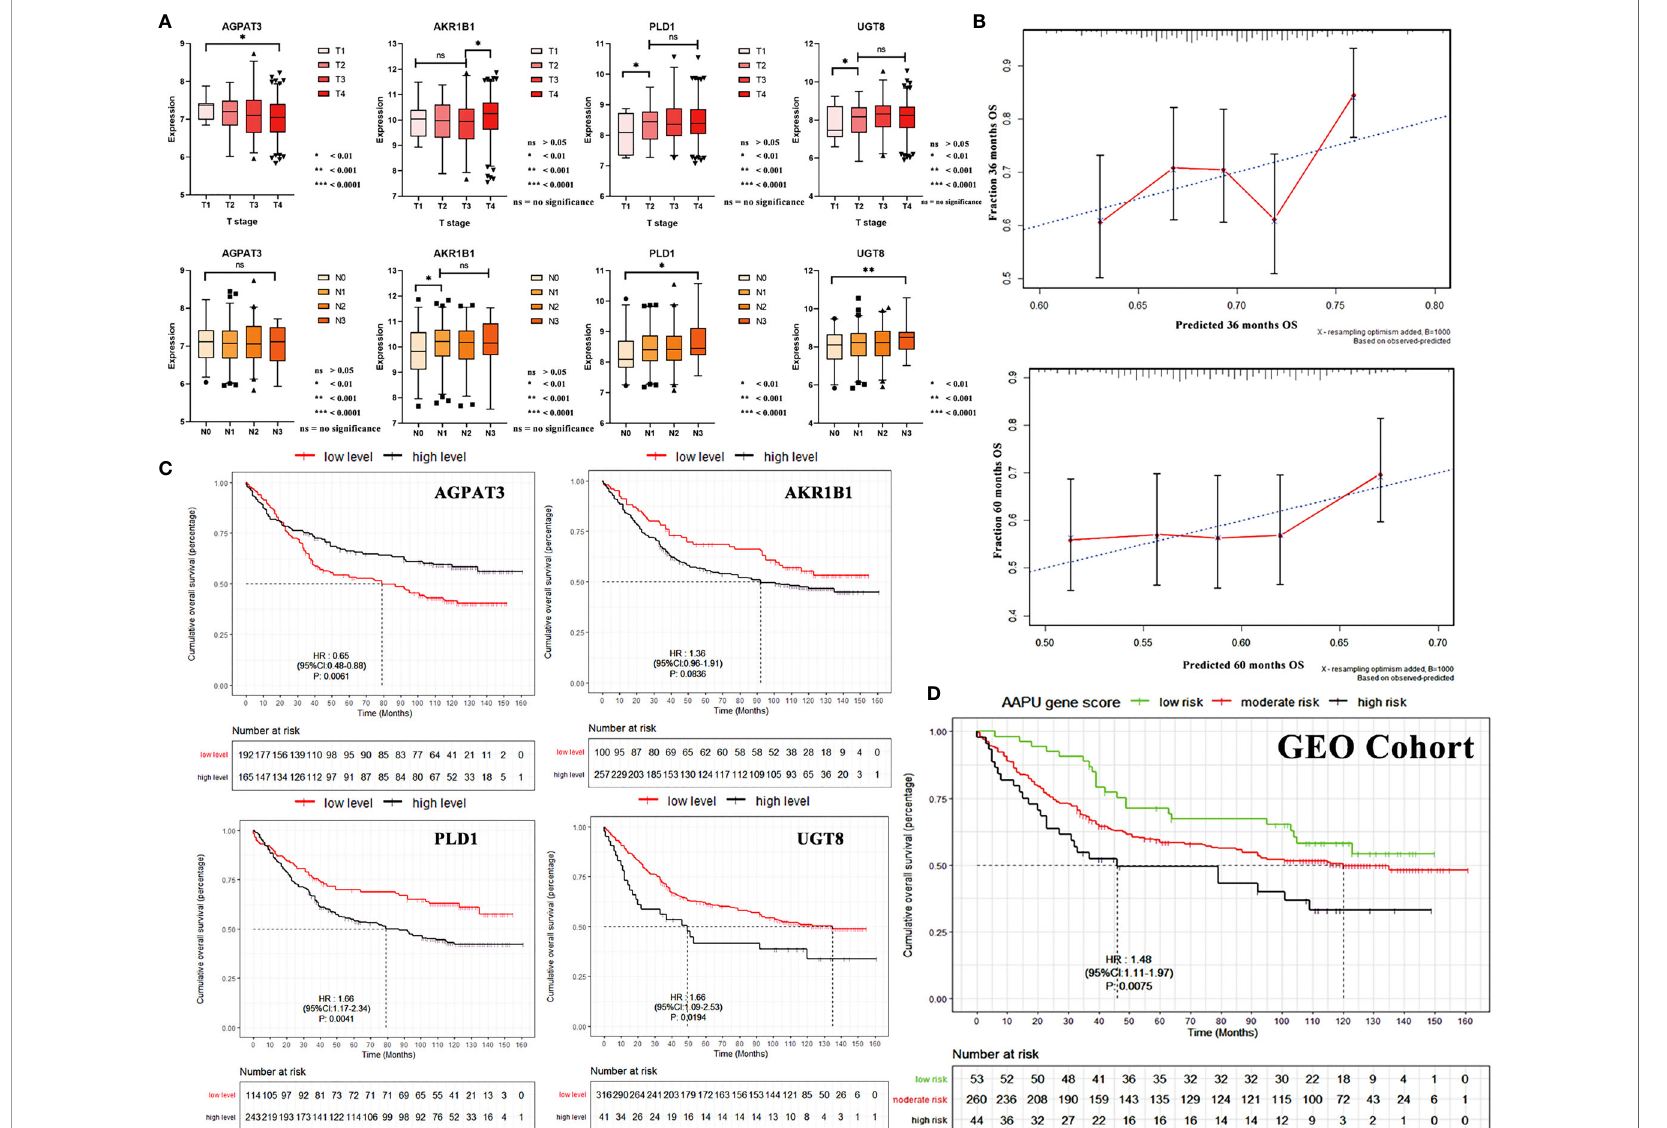
FIGURE 4 | (A) The mRNA expression correlation between AGPAT3, AKR1B1, PLD1, and UGT8 of TN stage in the validation cohort. (B) Three- and 5-year calibration curves of AAPU pro fi le. (C) KM survival curves of low- and high-level AGPAT3, AKR1B1, PLD1, and UGT8 in the validation cohort. (D) The KM survival curves of low-, moderate-, and high-risk “ AAPU ” genes pro fi le in the GEO